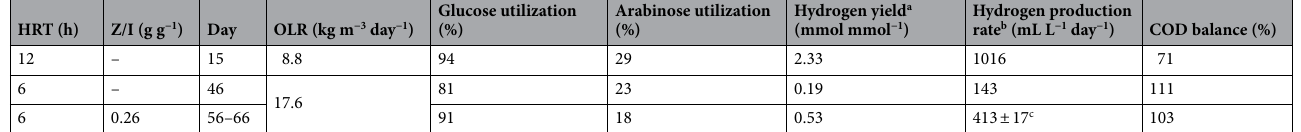
Table 3. Performance of the continuous bioreactor operation with C5 and C6-sugars. – Not added. a mmol of H 2 per mmol of substrate consumed. b Volume of H 2 produced per litter of bioreactor volume per day. c Average and standard deviation of values measured in 5 days in the indicated